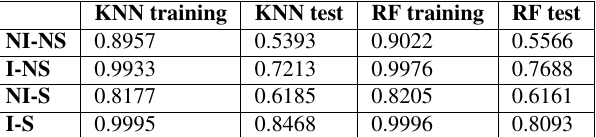
Figure 5. Scatter plot showing RSSI measurements after smoothing procedure divided into three classes corresponding to three rooms (R1, R2 and R3).